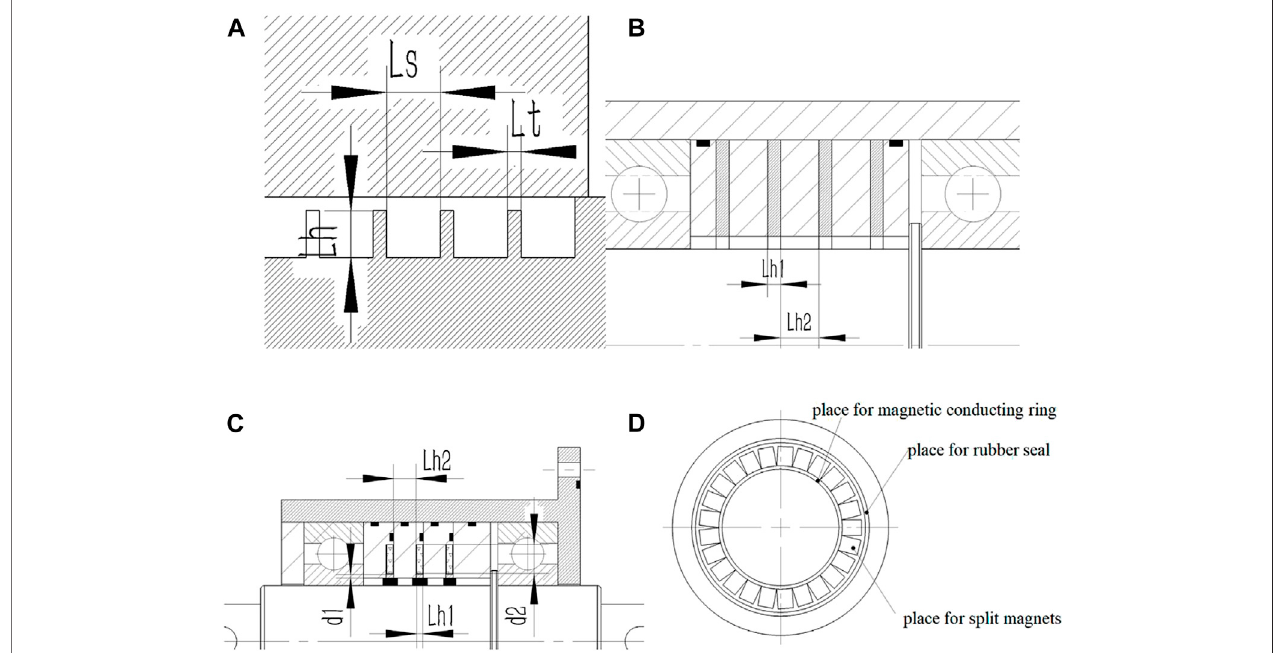
FIGURE 3 | Structural size of the FF seal. (A) Classic FF seal; (B) FF radial-charged seal; (C) FF split magnet seal; (D) nonmagnetic foundation.